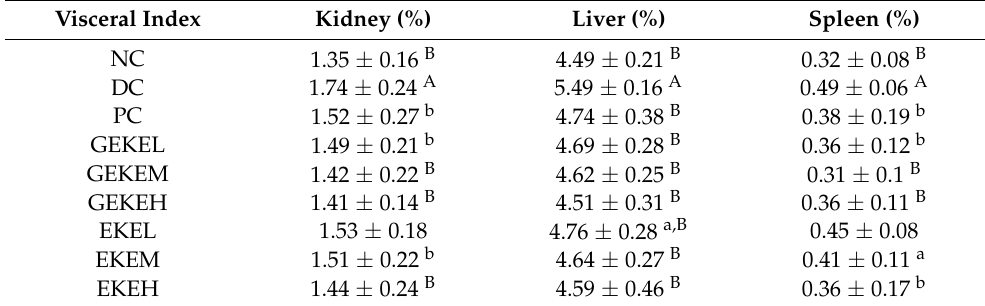
Figure 1. Effect of Gordon Euryale seed kernel extract (EKE) and germinated Gordon Euryale seed kernel extract (GEKE) on the body weight of diabetic mice. A total of 10 per group(n = 10); data are presented as mean ± SD values. A ( p < 0.01) and a ( p < 0.05) vs. the normal control; B ( p < 0.01) and b ( p < 0.05) vs. the diabetes control. Table 4. Visceral indexes in each group of mice (x ± s, n =